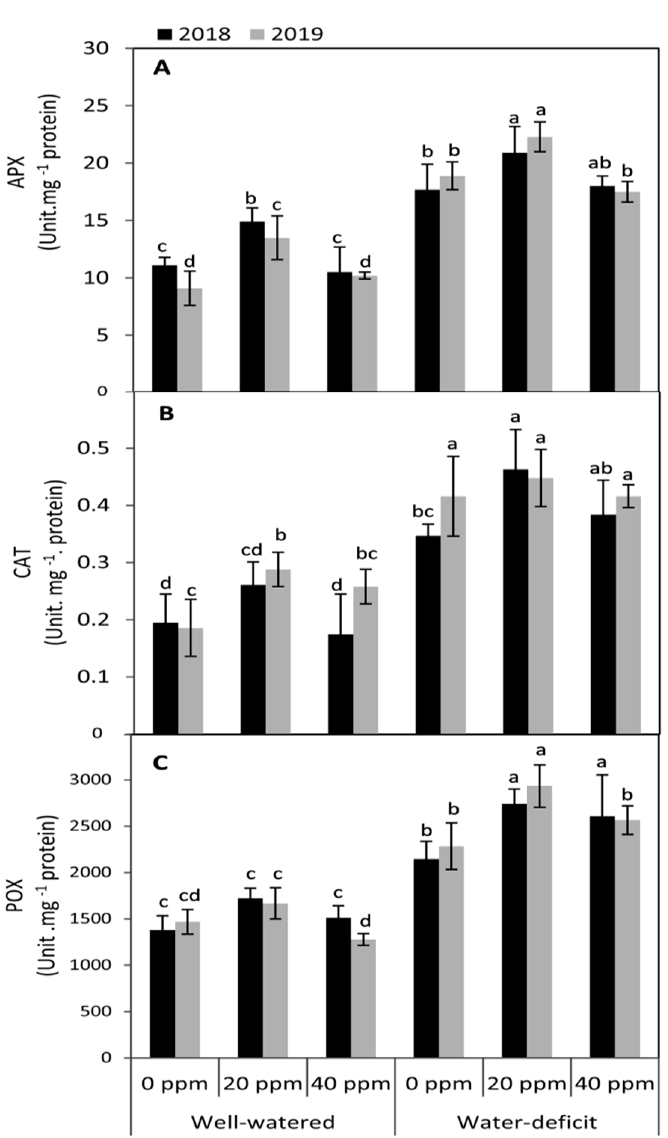
Figure 4. Effect of foliar application of melatonin (MT) at 0, 20 and 40 ppm on the activities of antioxidant enzymes; ascorbate peroxidase (POX; A ), catalase (CAT; B ) and peroxidase (POX, C ) of tomato plants grown under well-watered and water deficit conditions in the seasons of 2018 and 2019. Means of three replicates were presented ±SD. Different letters are significant differences, according to Duncan’s multiple range tests ( p < 0.05).